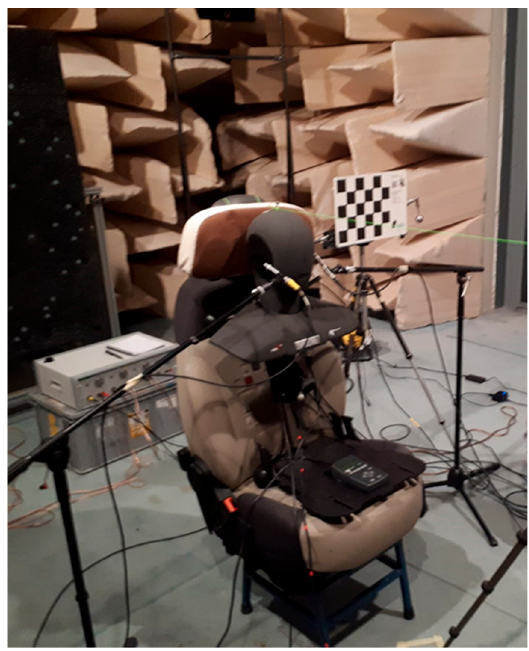
Figure 1. Semi-anechoic chamber at CIRA: the setup consists of a dummy seat with binaural head and configurable headrest.